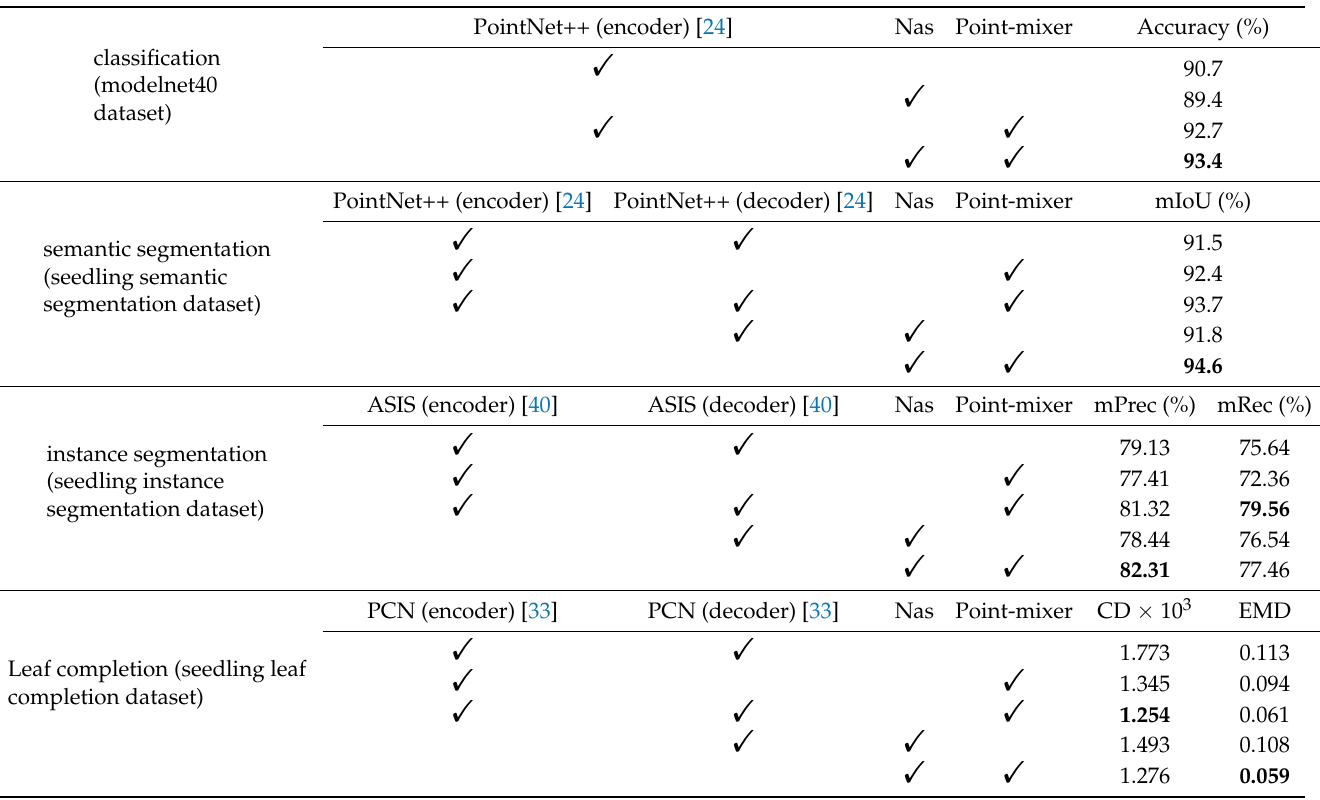
Table 9. The ablation analysis of MIX-Net. The checkmark stands for the use of a module. The best quantitative values are shown in